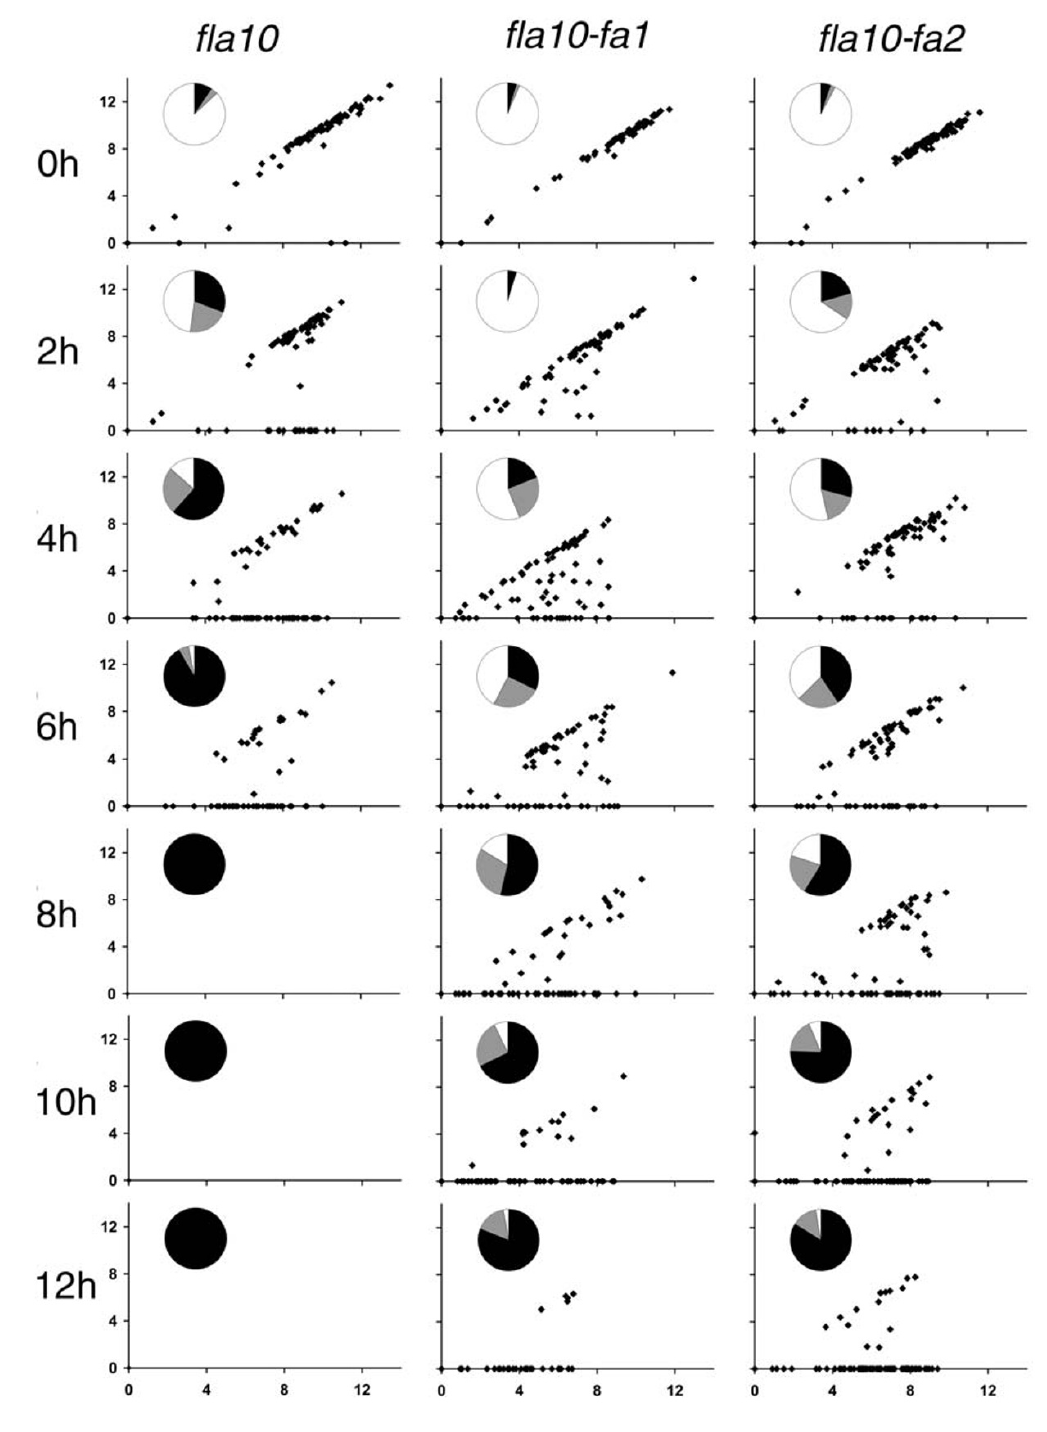
Figure 6 Double mutants of fla10 with fa1 or fa2 are slower to disassemble flagella at the restrictive temperature than fla10 single mutants. Scatter plots of 33°C timecourses for fla10 , fla10 - fa1 and fla10 - fa2 ; plots prepared as described in the legend to Figure 3. TAP cultures were resuspended in pre-warmed TAP media at t = 0 h. No free flagella were seen in fla10 - fa1 or fla10 - fa2 cultures at any